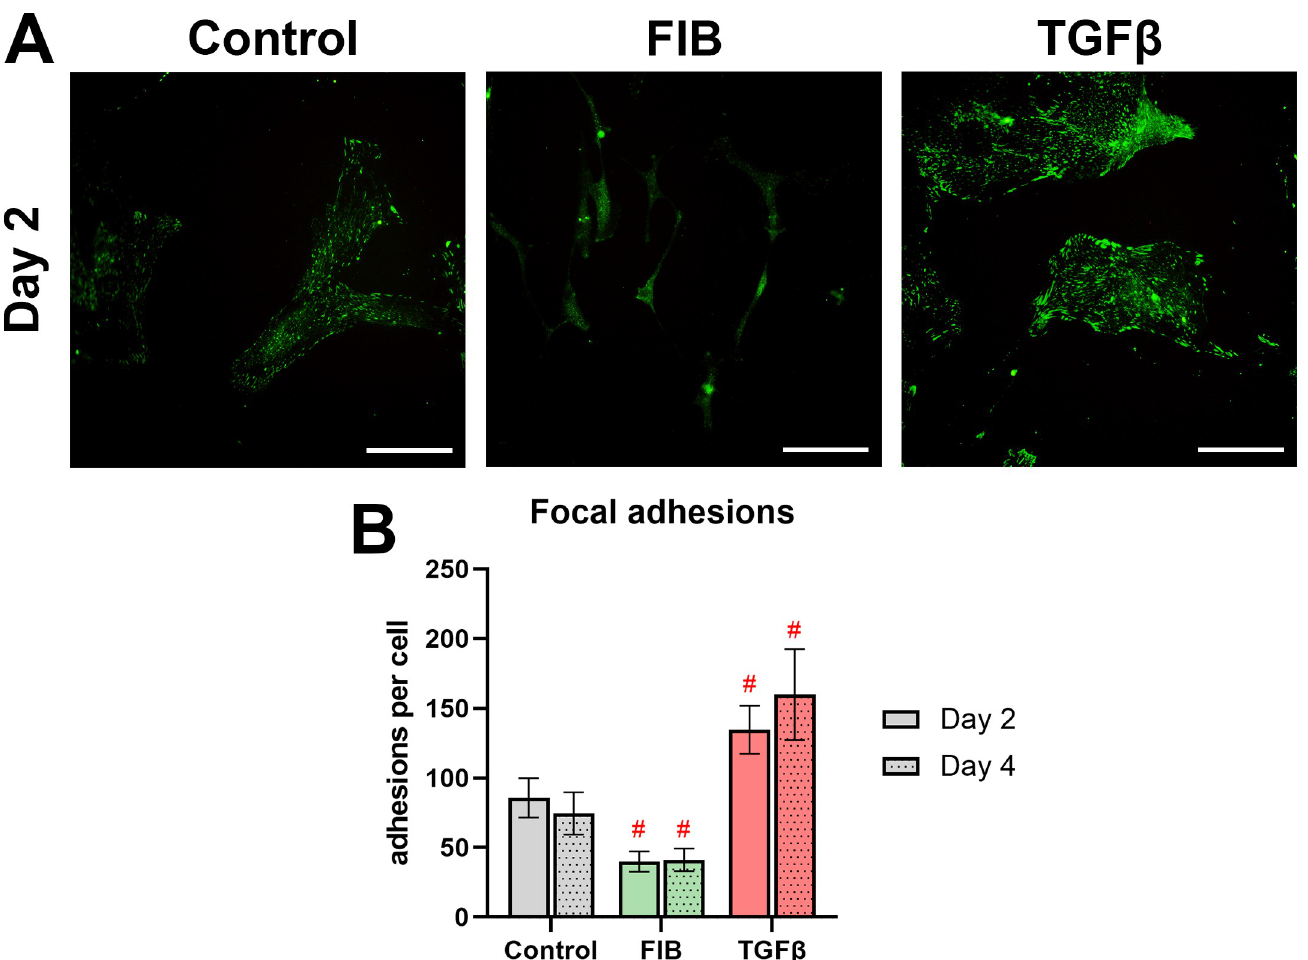
Fig 6. FGF-2 inhibits focal adhesion formation. (A) shows paxillin staining of hVICs on day 2, scale bars represent 100 μ m. Representative images of day 4 did not appreciably differ from day 2, and are available in the supplementary materials (S3). (B) is the number of mature focal adhesions per cell. n = 4 biological replicates were used, 10 images per replicate per group. Experimental groups were compared to control using a 2-way ANOVA. � p < 0.05, #p < 0.01, error bars represent 95%